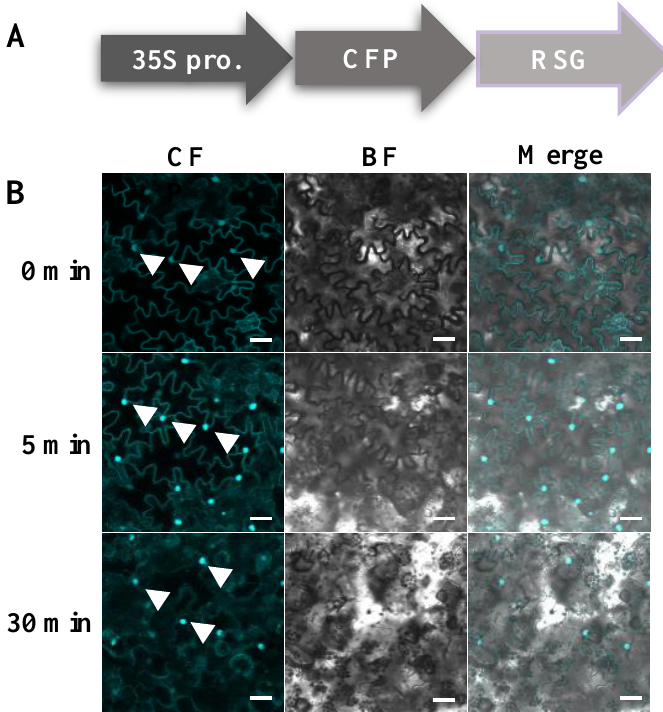
Figure 2. The B. cereus AR156 induces nuclear import of RSG in N. tabacum cells. ( A ) Constructs of 35S-driven RSG-CFP; ( B ) confocal microscopy observation of transgenic tobacco overexpresses Figure 2. B. cereus AR156 induces nuclear import of RSG in N. tabacum cells. (A) Constructs of 35S- RSG-CFP upon treatment of B. cereus AR156 suspension in 5 min and 30 min. RSG tagged with CFP were stably expressed in transgenic N. tabacum and analyzed by confocal microscopy after B. cereus AR156 treatment. CFP signal is in cyan. Images are single confocal sections, representative of images obtained in three independent experiments. Scale bars = 40 µ M. White arrows indicate observed nuclear of tobacco cells. Scale bars = 20 µ m. Three independent experiments were performed for each assay with similar